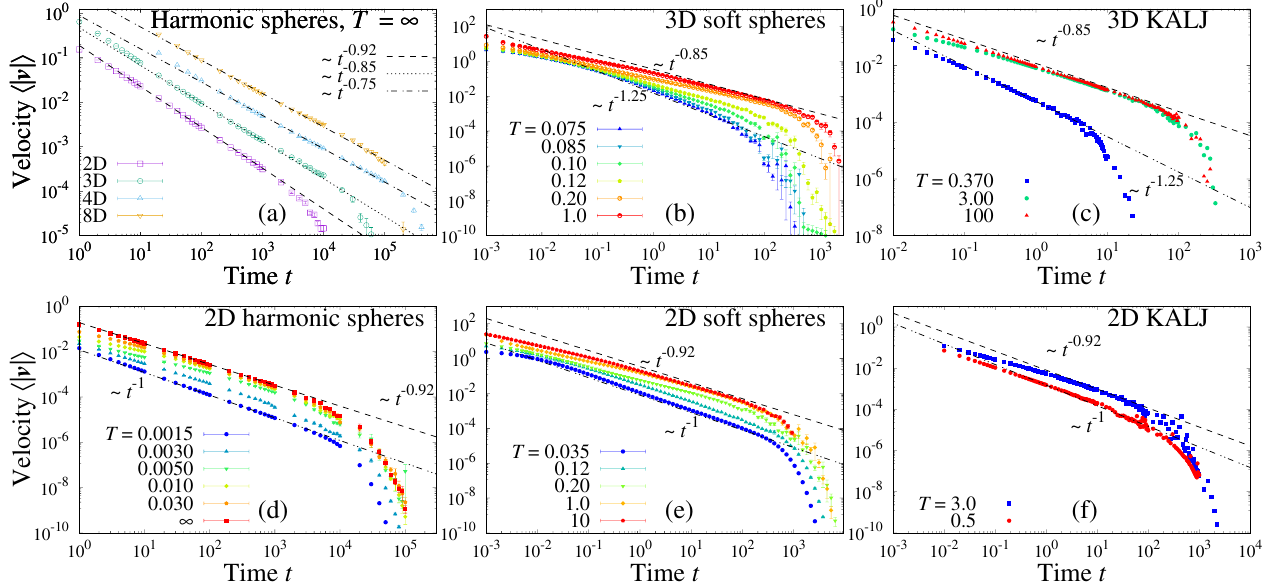
FIG. 2. The velocity hj v ð t Þji as a function of time t for the harmonic spheres in two, three, four, and eight dimensions (a), the three- dimensional soft spheres (b), the Kob-Andersen Lennard-Jones model (KALJ) (c), the two-dimensional harmonic spheres (d), the soft spheres (e), and the Kob-Andersen Lennard-Jones model (f). In (a), the number of particles is N ¼ 64000 for D ¼ 2 , N ¼ 65536 for D ¼ 3 and D ¼ 4 , and N ¼ 16384 for D ¼ 8 (data are shifted vertically for clarity). In (b) and (d) – (f), N ¼ 96000 , 64000, 64000, and 125000, respectively. In (c), N ¼ 27135 at T ¼ 0 . 37 and N ¼ 76800 for other